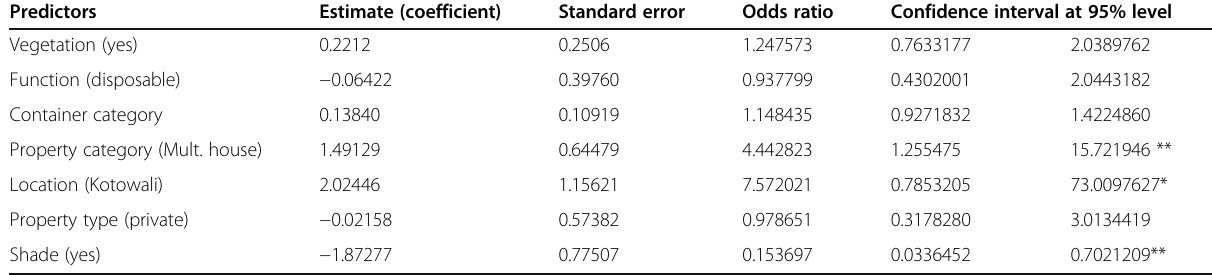
Table 4 Zero-inflated negative binomial regression of Aedes positive with the background characteristics of water-holding